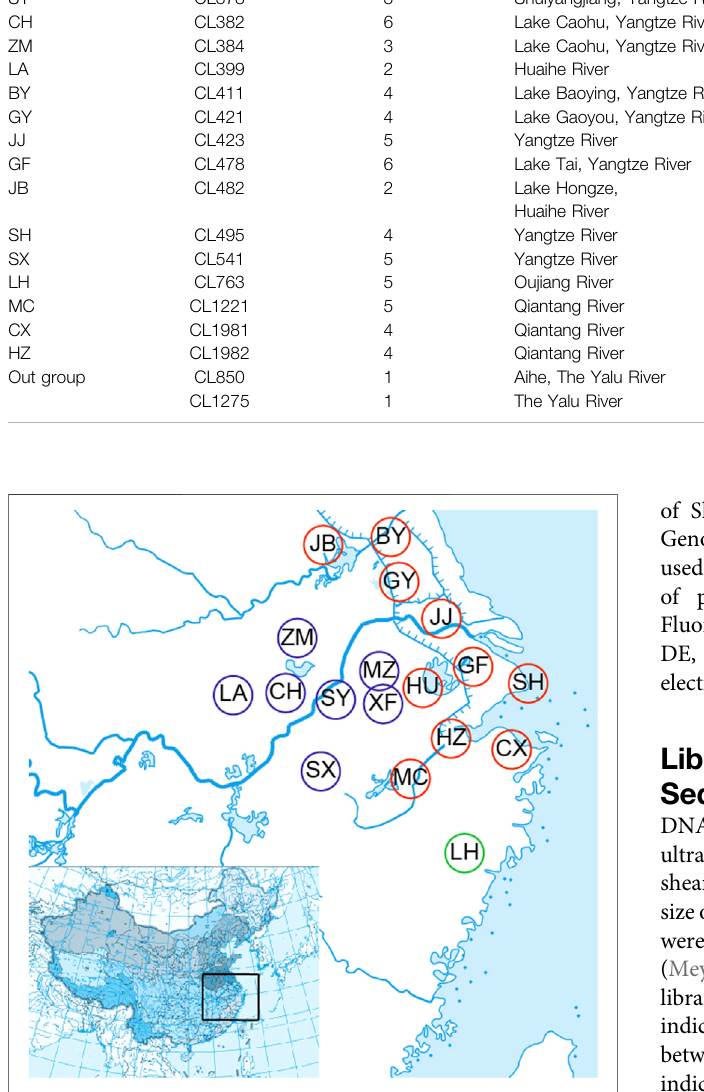
FIGURE 1 | Eighteen sample collecting sites of the Odontobutis potamophilus including Meicheng (MC), Cixi (Cx), Hangzhou (Hz), Huzhou (HU), Baoying (by), Gaoyou (Gy), Jingjiang (JJ), Guangfu (GF), Jiangba (JB), Shanghai (SH), Meizhu (MZ), Xingfu (XF), Chaohu (CH), Shuyang (SY), Zhongmiao (ZM), Liu (LA), Shexian (SX), and Linhai